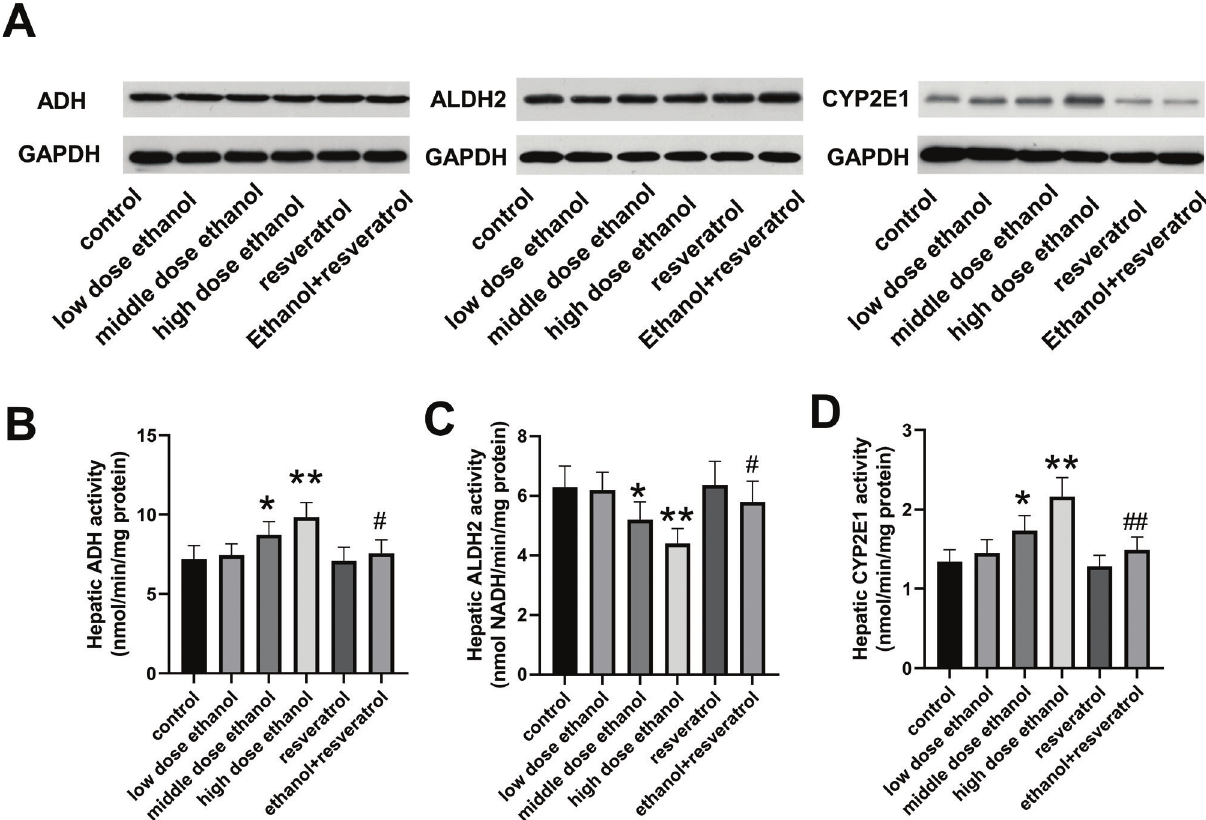
Fig. 2. Effects of ethanol and Resveratrol treatment on the protein expression and activity level of hepatic ADH, ALDH2, and CYP2E1. (A) The relative protein expression of hepatic ADH, ALDH2, and CYP2E1 was analyzed by Western blot analysis. Rat liver tissue was separated for hepatic enzymatic assay of ADH (B), ALDH2 (C), and CYP2E1 (D). # P < 0.05, ## P < 0.01 vs high dose ethanol group; *P < 0.05, **P < 0.01 vs control